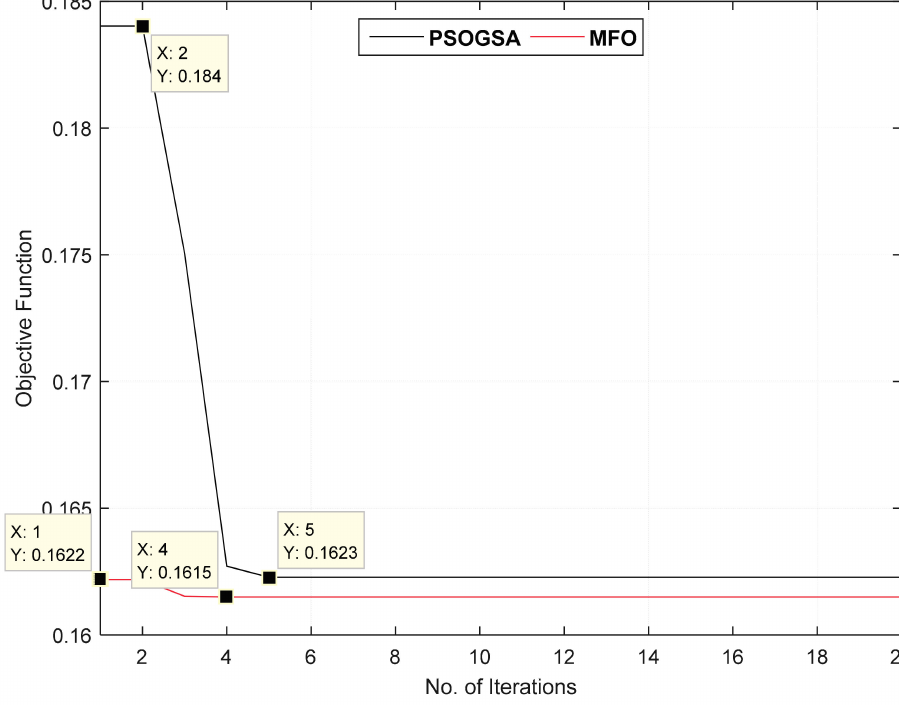
Figure 13. The change of objective function (LVCI) with iterations number for 33-bus at 0.866